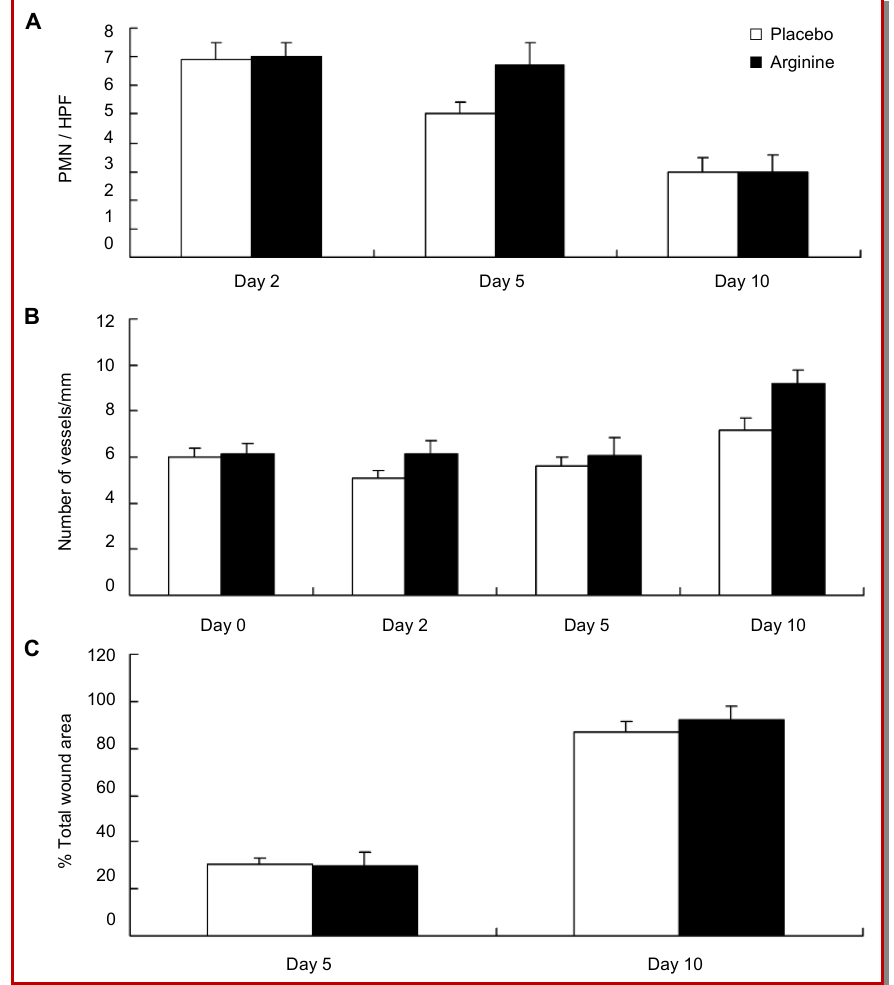
Figure 2: Evaluation of wound